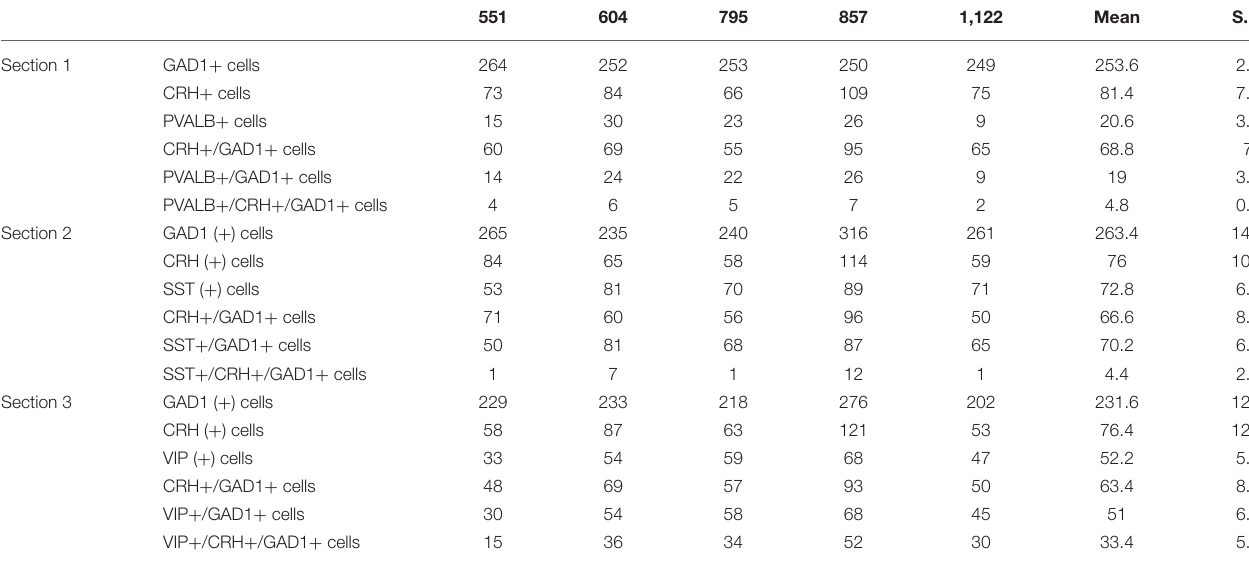
TABLE 4 | Total number of SST-, VIP-, PVALB-expressing CRH + neurons counted in human